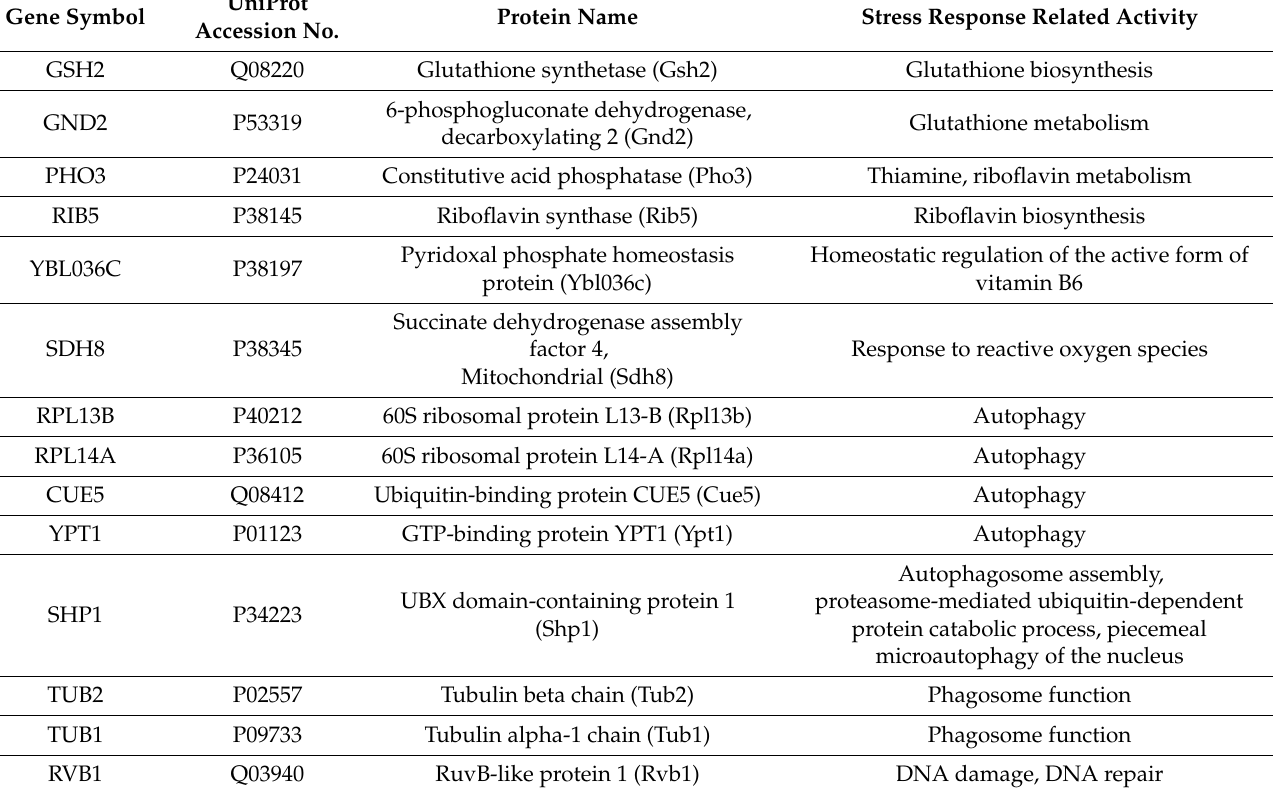
Table 1. Stress response related